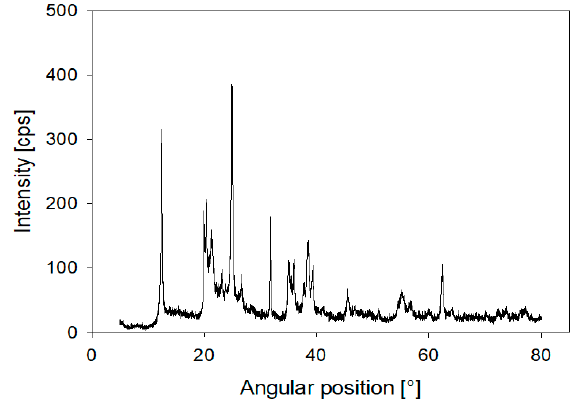
Figure 1. X-ray diffraction (XRD) for kaolin powder.